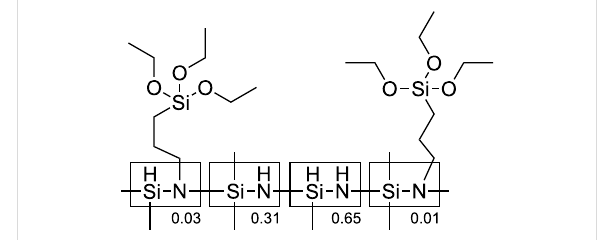
Figure 1: Molecular structure and distribution of the functional groups of the polysilazane precursor provided by the Clariant Company.